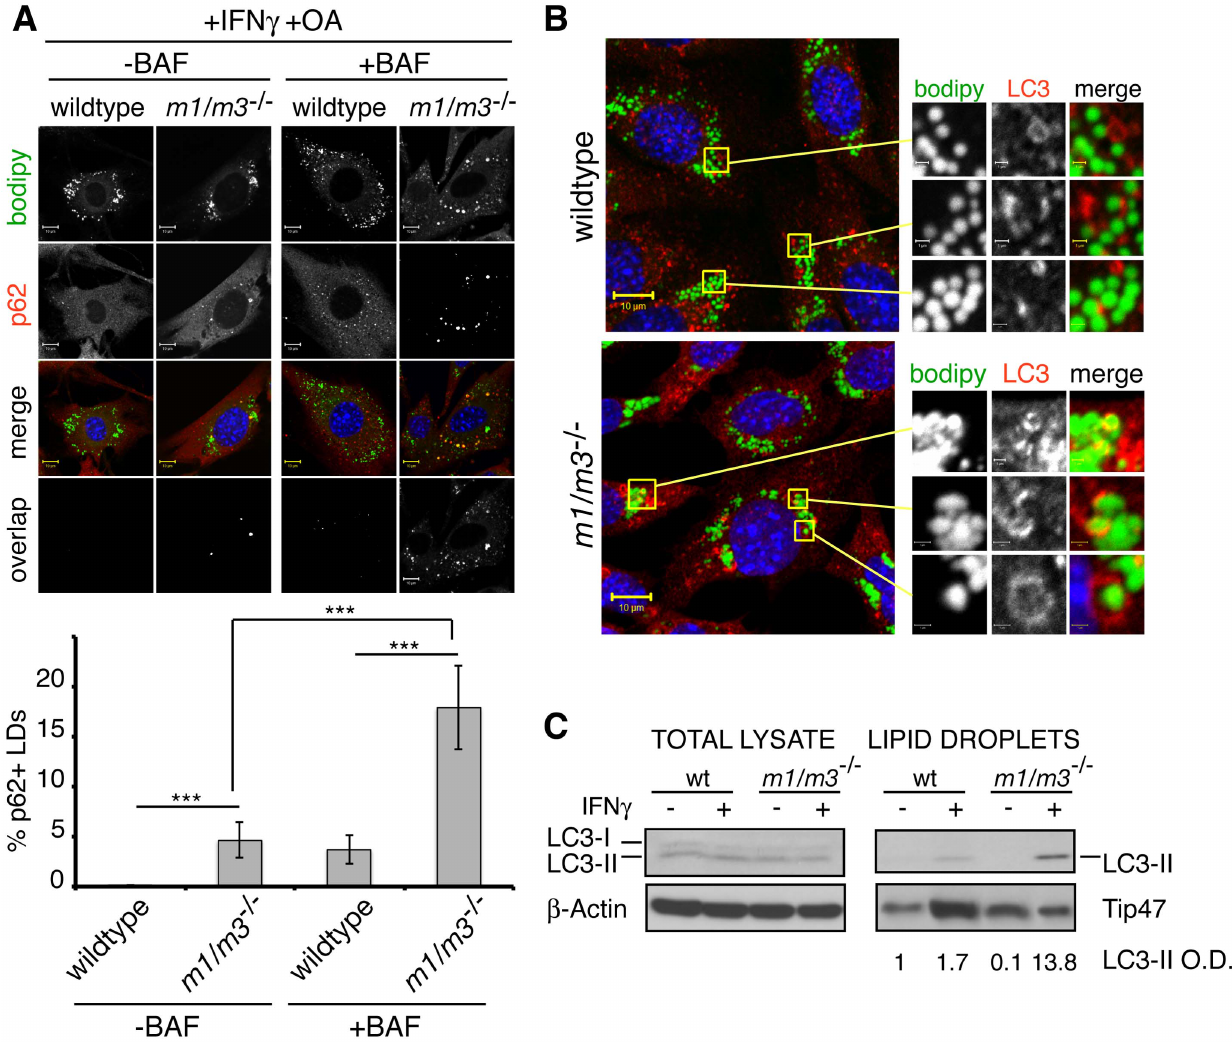
Figure 8. IRGM-deficient LDs recruit p62 and LC3-II. ( A and B ) Wildtype and Irgm1/m3 2 / 2 MEFs were treated overnight with OA and IFN c and stained with BODIPY and anti-p62 or anti-LC3, respectively. Representative images of at least 3 independent experiments are shown. Where indicated, cells were treated with Bafilomycin (BAF). ( A, lower panel ) Quantitative analyses of p62 co-localization with LDs were done using MBF- ImageJ software as described in Materials and Methods (***, p , 0.005). ( C ) Total cell lysates and LD protein preparations from the indicated samples were analyzed for LC3 protein expression. Densitometric analyses for protein quantification were carried out using ImageJ 1.45 s software. The relative optical density (O.D.) for LC3-II expression normalized against expression of the LD marker Tip47 is listed below the corresponding lanes in arbitrary units.